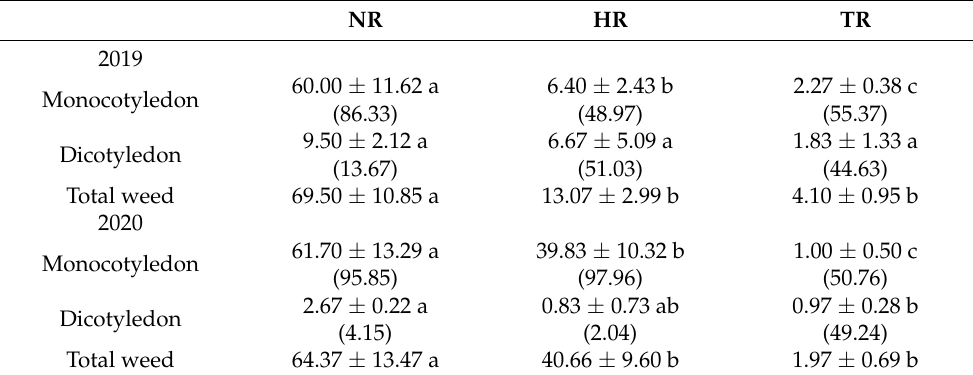
Table 2. Results of one-way analysis of variance of weed aboveground dry matter (g m − 2 ) of treat- ments (NR, no crop residues retention; HR, half crop residues retention; TR, total crop residues retention) during the study period. NR